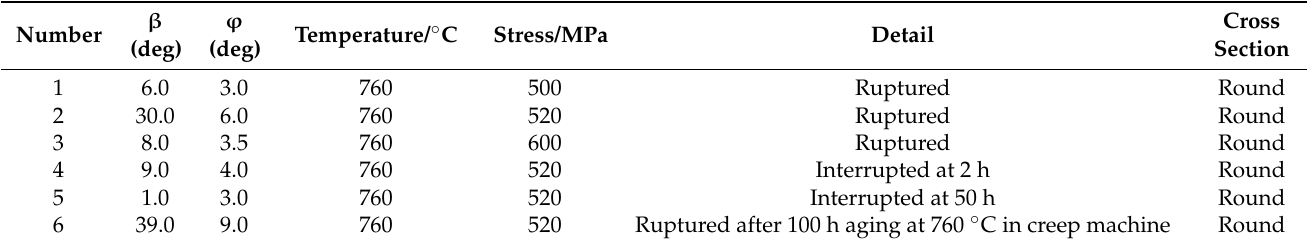
Table 2. The crystal orientations of creep specimens and creep conditions. (Number refers to the specimen number in Figure